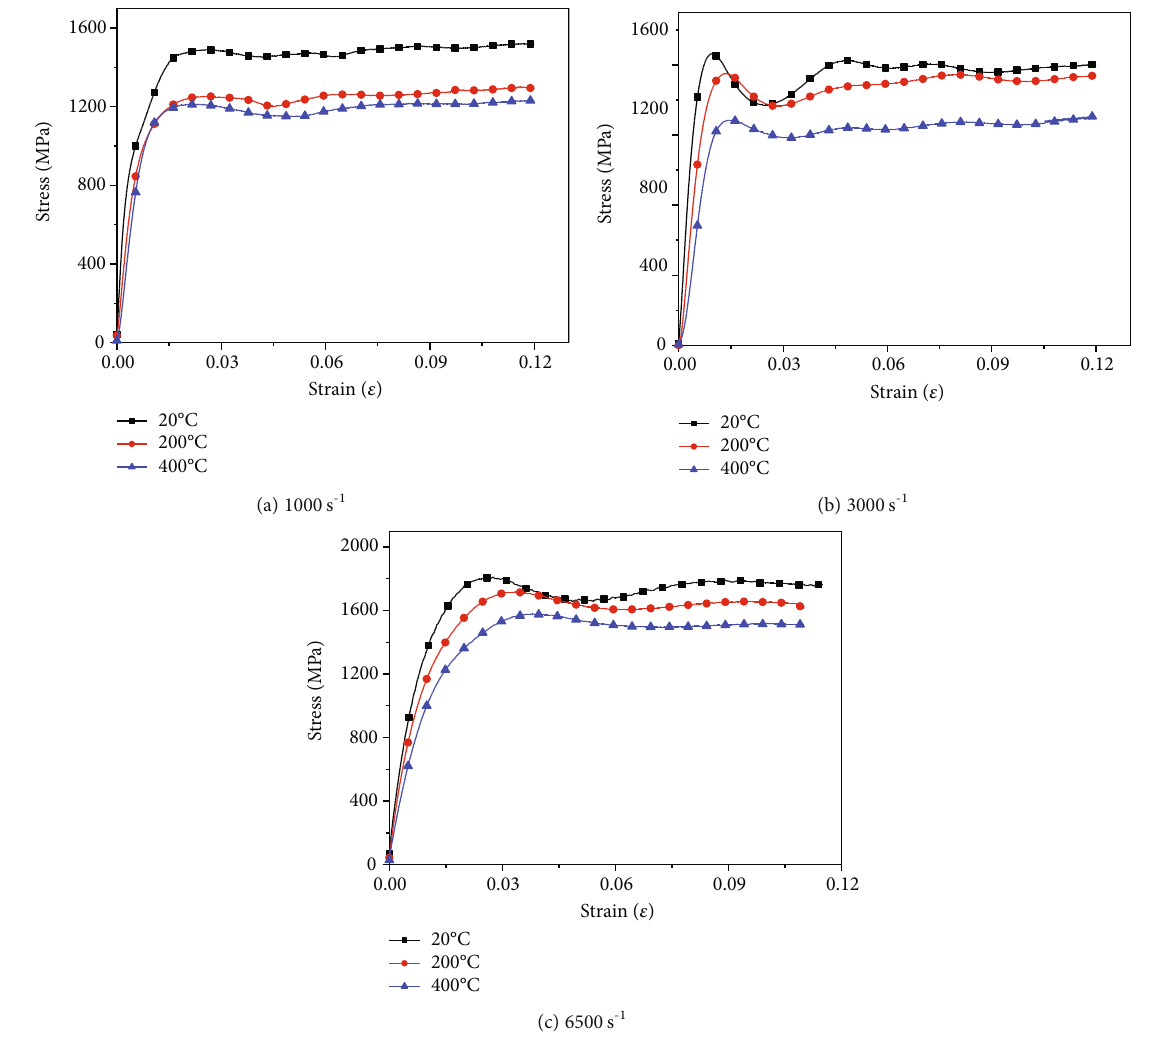
Figure 11: Stress-strain relation of specimens.